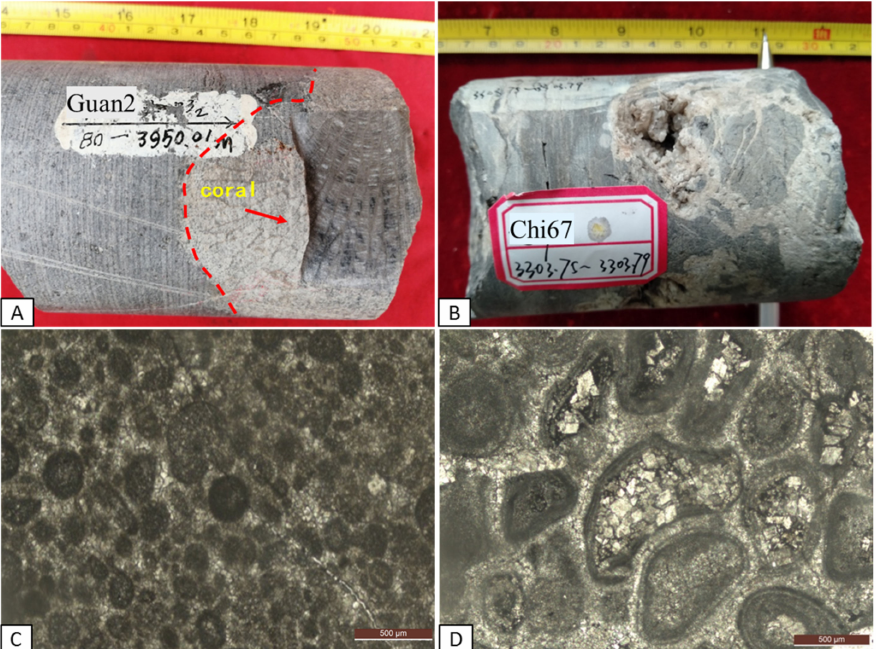
Figure 3. Petrological characteristics of platform margin shoal in P 2 m 2 a, Eastern Sichuan. ( A ) Bioclastic limestone with the development of coral in well Gou2. ( B ) Dolomite in well Chi67; the pores are filled with saddle dolomite. ( C ) Sparry oolitic and arenaceous limestone in well Wo83. ( D ) Sparry oolitic limestone in well Wo83, in which the oolitic particles are dolomitized.